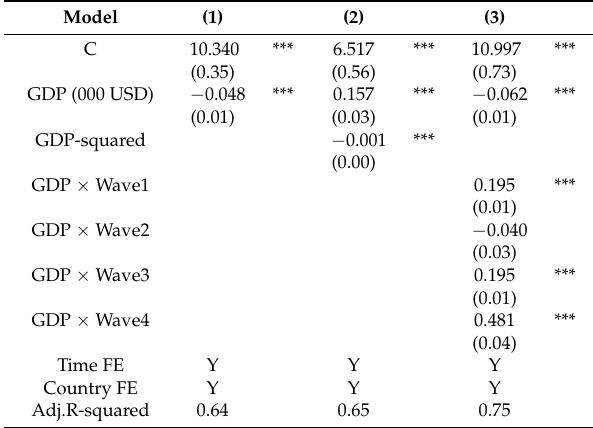
Table 3. Regression results from fixed-effects